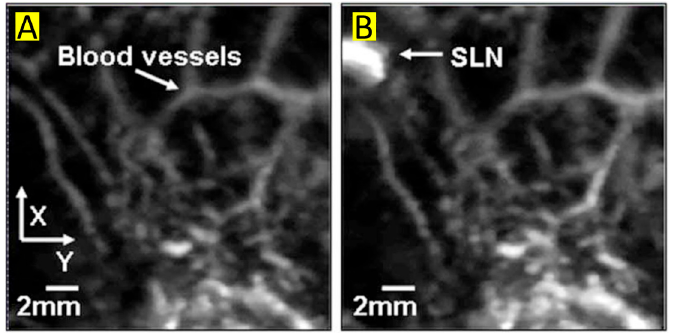
Figure 3. ( A ) optoacoustic image of control without methylene blue at 635 nm ( B ) optoacoustic image of SLN 52 min after injection of MB at 635 nm. Figure from [55] reproduced with permission from the publisher.